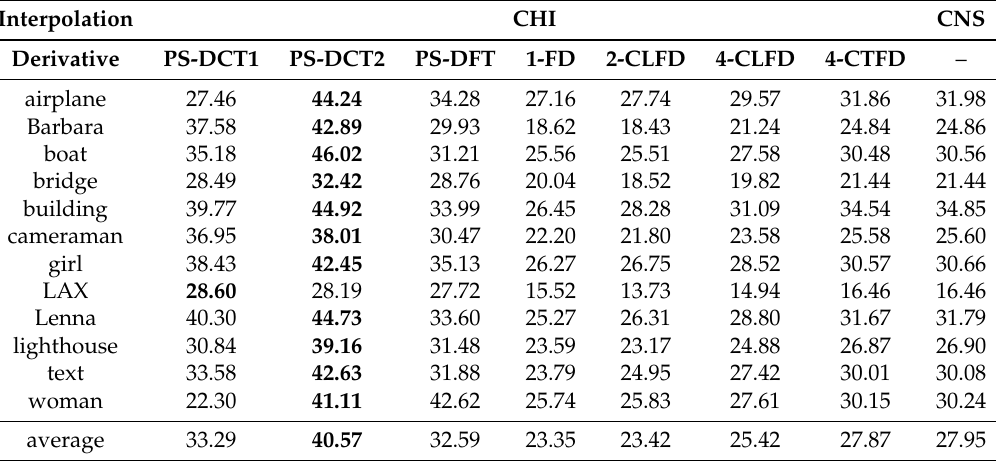
Table 2. SNRs (dB) of the final output after successive image translation ( m = 1 )